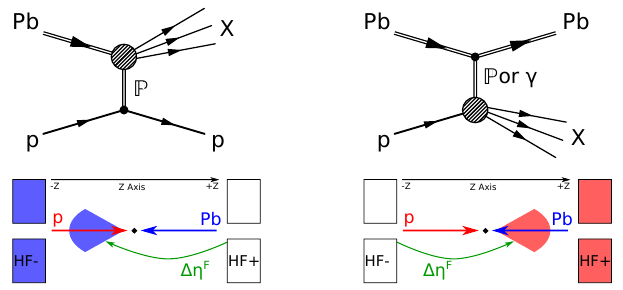
Figure 1: Top: Feynman diagrams of pPb events with large rapidity gaps for IPPb (left) and IPp or γ p (right). Bottom: topologies of such events. The blue (red) cones indicate the products of diffractive dissociation for the lead ion (proton). The rapidity gaps are marked with green